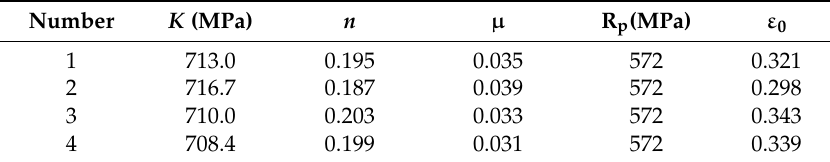
Table 7. Determined combination of material parameters and friction coefficient µ